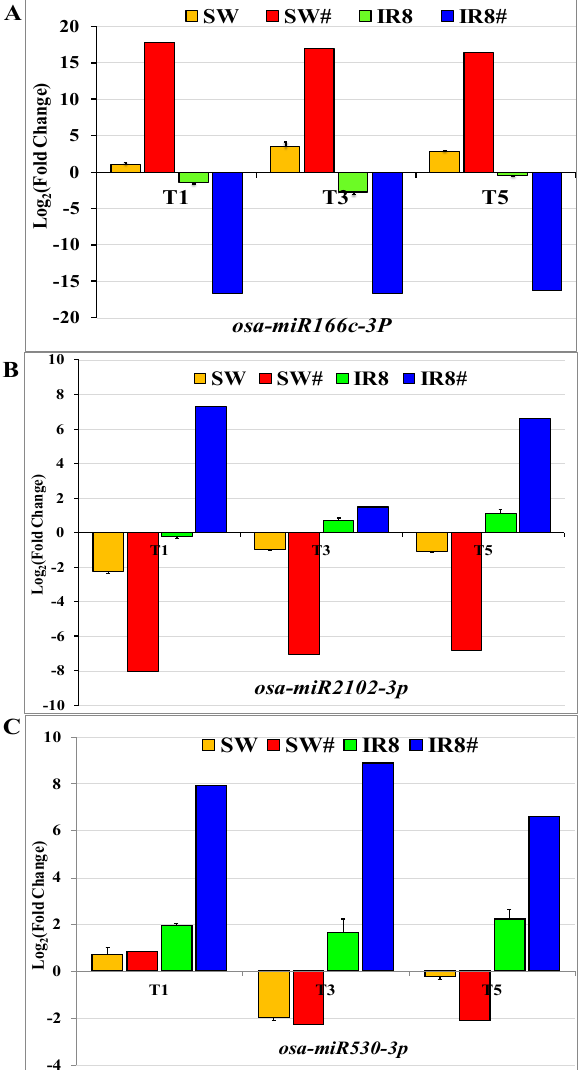
Figure 5. Validation of three differentially expressed known miRNAs, ( A ) osa - miR166c-3p , ( B ) osa - miR2102-3p , and ( C ) osa - miR530-3p through miRNA-specific qRT-PCR, identified from an miRNA sequencing results of Swarnaprabha and IR8 after low light treatment as compared to control. Each miRNA was amplified using mRQ 3 (cid:48) primer along with miRNA-specific and U6-specific 5 (cid:48) primers. The primer sequences have been provided in Table S3. (# = miRNA-seq). Error bars are ± SD of the average of three miRNA-specific q RT-PCR